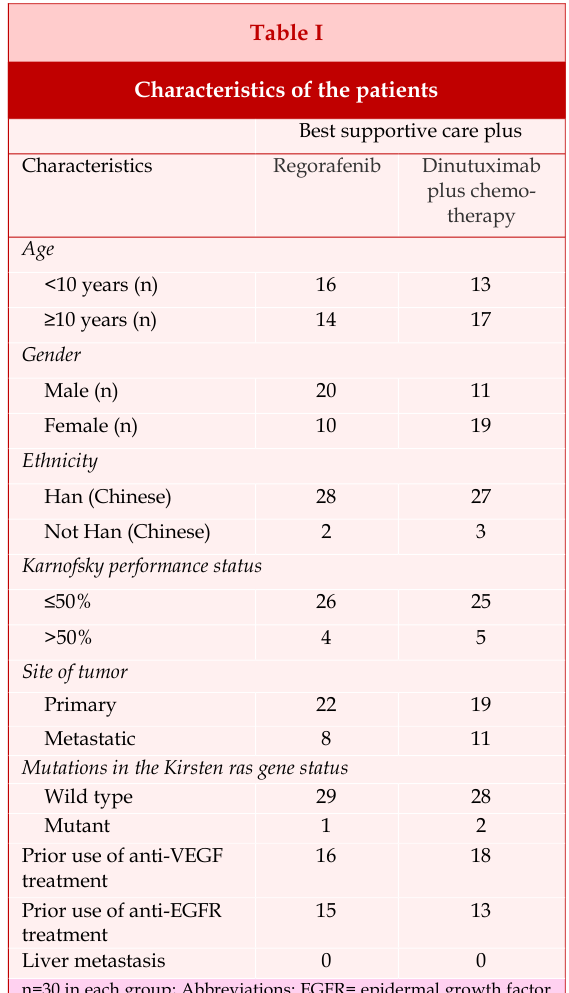
Characteristics of the patients Best supportive care plus